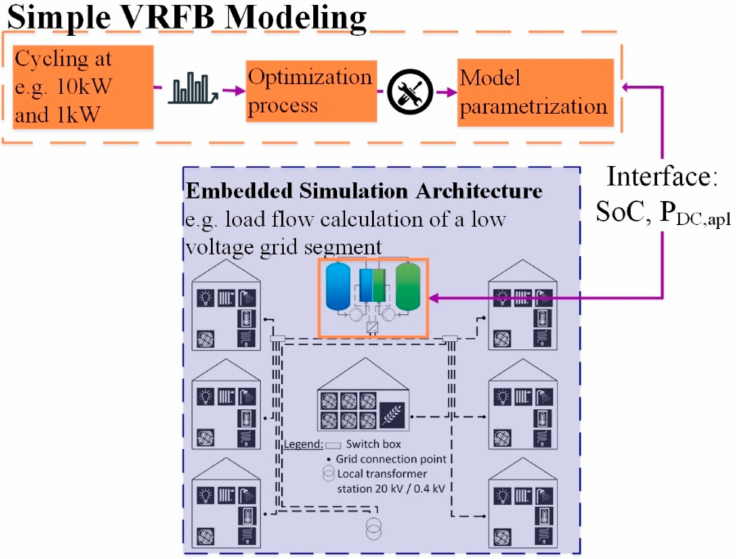
Figure 5. Schematic illustration of the complete simulation process (orange) and the interface to superimposed simulation architectures